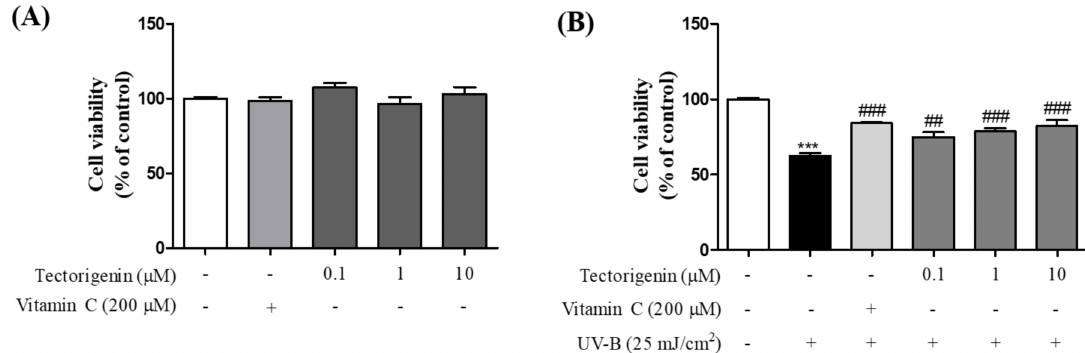
Figure 2. Inhibitory effects of tectorigenin against UV-B-induced cell death in HaCaT cells. The cells were treated with tectorigenin at 0.1, 1, and 10 µ M or vitamin C at 200 µ M for 24 h ( A ). The cells were irradiated with 25 mJ/cm 2 UV-B and treated with tectorigenin at 0.1, 1, and 10 µ M or vitamin C at 200 µ M for 24 h ( B ). Cell viability was measured by an MTT assay. Values are given as the mean ± the standard error of the mean (SEM). *** p < 0.001 versus control group, ## p < 0.01, ### p < 0.001 versus UV-B-only treated group.